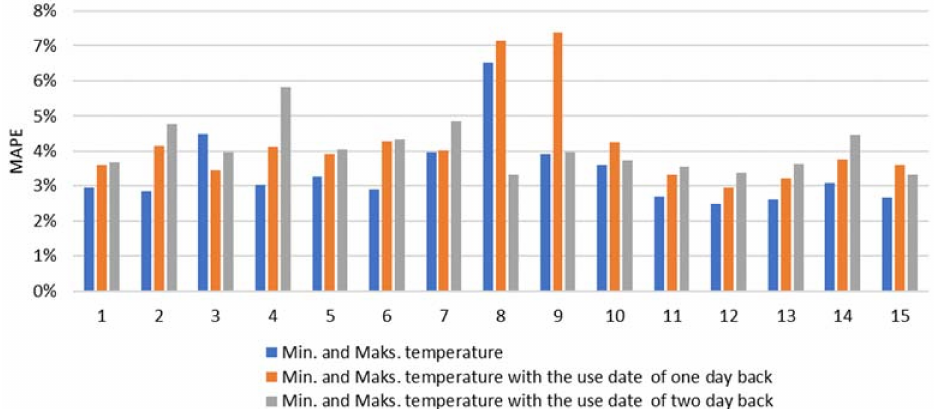
Figure 8. MAPE error results for the models using the min/max temperature.